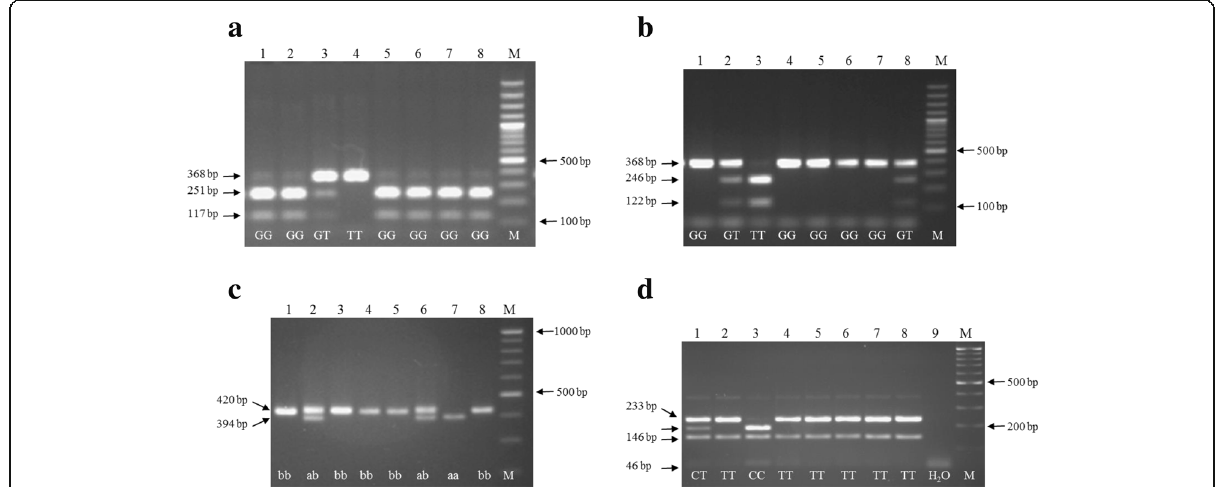
Fig. 1 Genotyping of rs1799983 with the restriction enzymes Ban II (panel a ) and Mbo I (panel b ), VNTR intron 4 (panel c ) and rs2070744 with the restriction enzyme Msp I (Panel d ) using